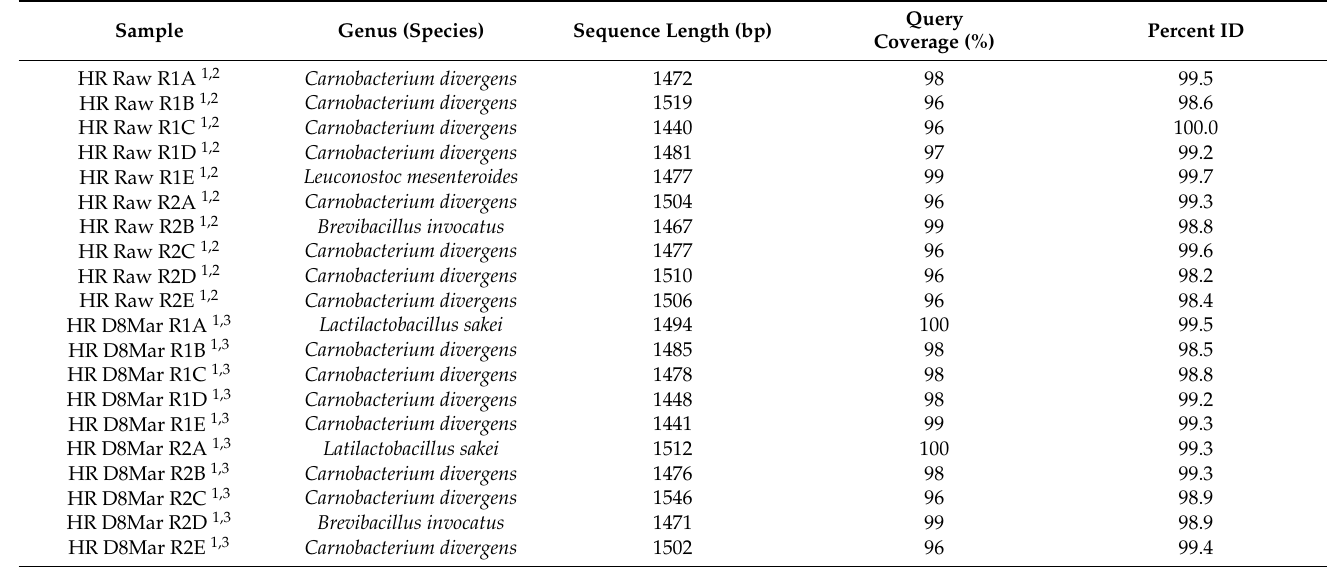
Table 3. Bacterial isolates identified from High River-JBS (HR) based on 16S rRNA gene sequencing analysis of isolates obtained from raw beef (Raw) and marinaded beef after 8 days of drying (D8) for trial 1 (R1) and trial 2